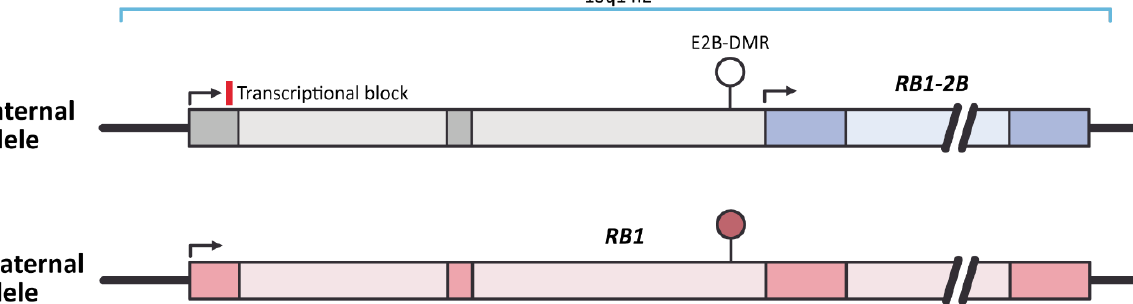
Figure 3. The schematic representation of RB1 imprinting (based on genome assembly GRCh38.p12). Unmethylated E2B-DMR on the paternal allele activates expression of RB1-2B , which acts as a roadblock for the regular RB1 transcript on the same allele, while methylation of E2B-DMR on maternal allele allows normal expression of RB1 . Filled ellipse represents methylated E2B-DMR, and open ellipses represent unmethylated DMRs. Dark and light boxes indicate exons and introns of RB1 gene, respectively.